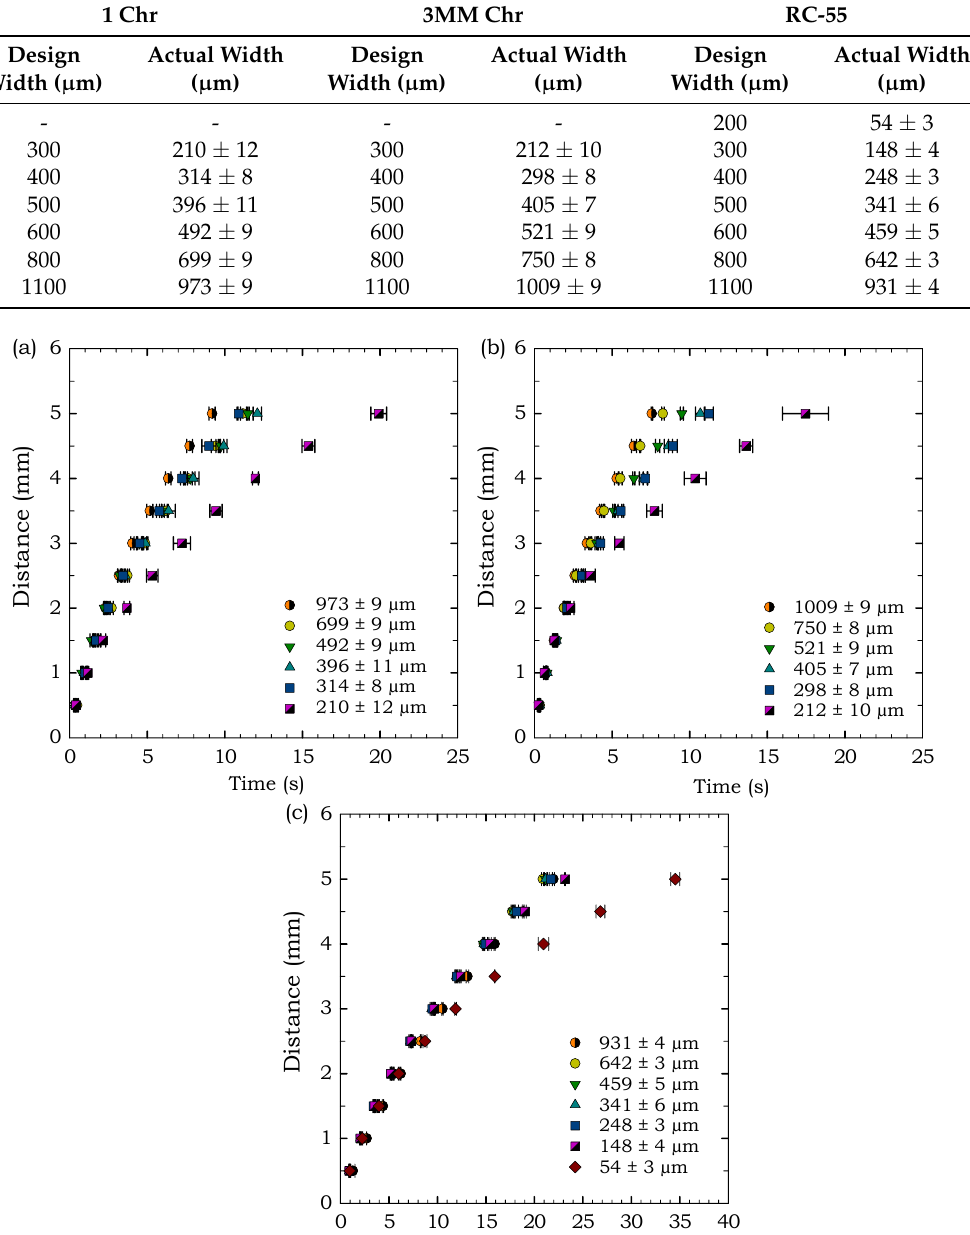
Table 2. Design widths and corresponding actual widths fabricated from different paper types used for flow speed measurements.